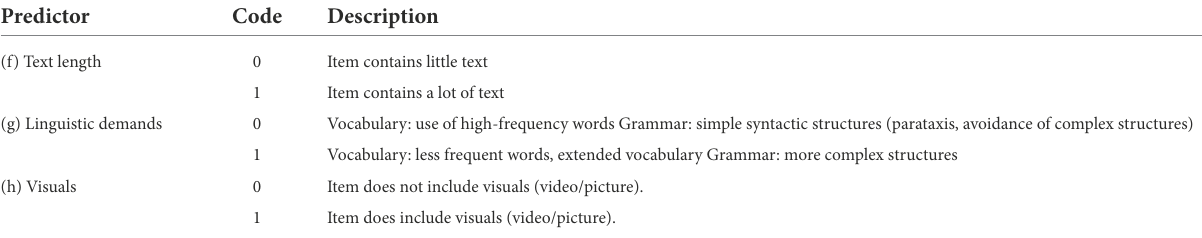
TABLE 5 Domain 3 of the identified item characteristics (predictors classified as formal task features).